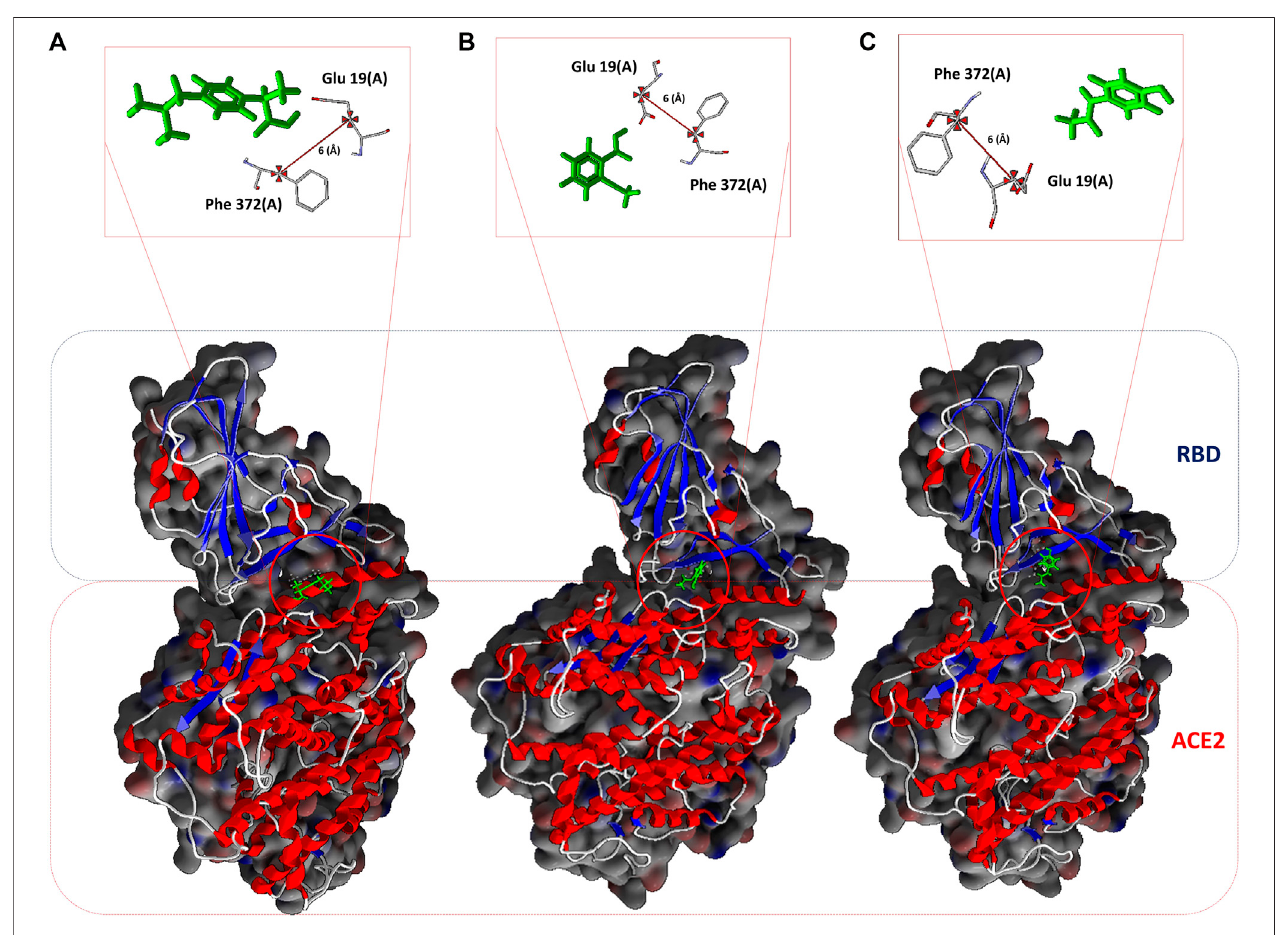
FIGURE 1 | NSAIDs docking at the interface of the RBD-ACE2 protein complex. (A) Ibuprofen_CID_3672, (B) Aspirin_CID_2244, and (C) Acetaminophen_CID_1983.In the upper part, the arbitrarily chosen residuals forthe subsequent analysisof molecular dynamic areobserved, asthey areinvolved in the interaction and at a distance of 6 Å from each